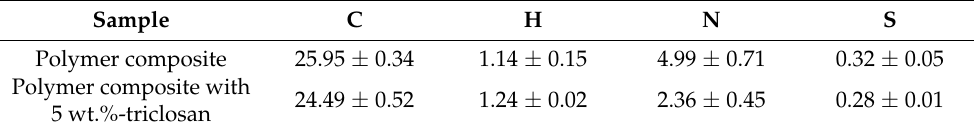
Table 6. The microelemental analysis of polymeric composites on a CHNS analyzer (in wt.%). Sample C H N S Polymer